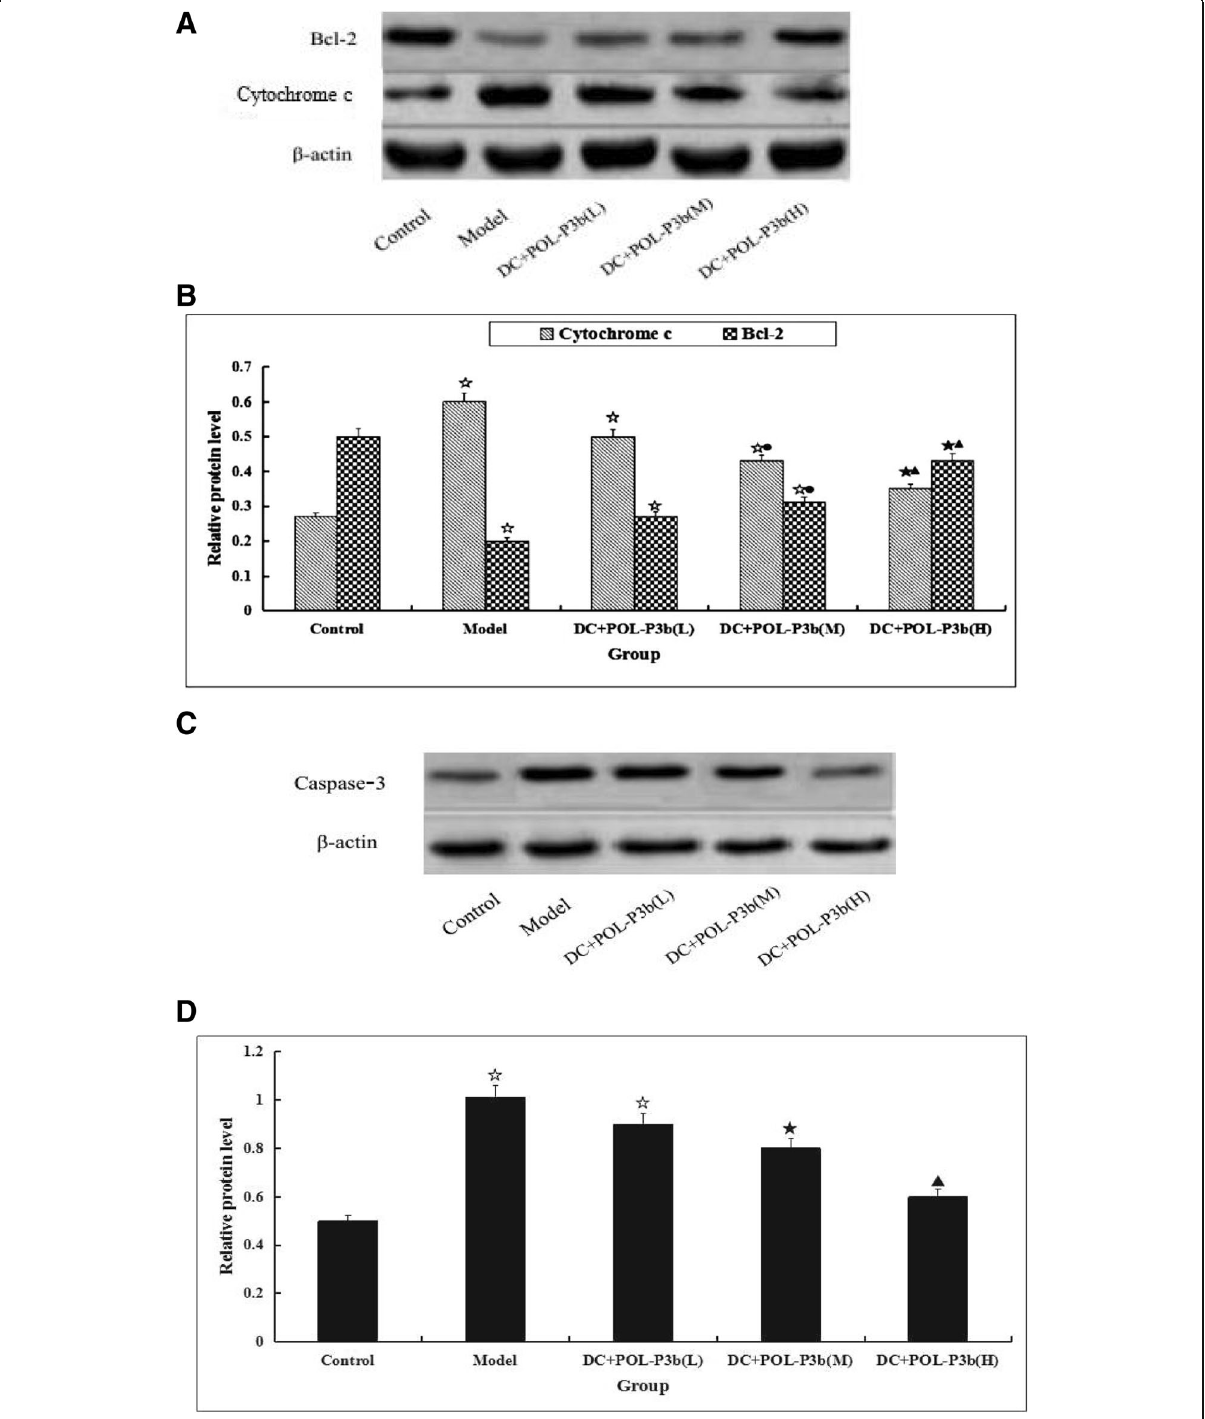
Fig. 4 Effect of POL-P3b by oral administration on intrinsic apoptotic-related proteins in intestinal DC a Expression of Bcl-2 and cytosolic Cytochrome c in intestinal DC was analyzed by western blot in three independent experiments. c Expression of caspase-3 in DC were analyzed by western blot in three independent experiments. b and d Statistical bar graph of the protein expression. Immunoblots were scanned within the linear range and quantitated using the computer software. The quantitated values represent the mean ± S.D. compared with control, P < 0.05, ☆ P < 0.01; compared with model, ● P < 0.05, P <